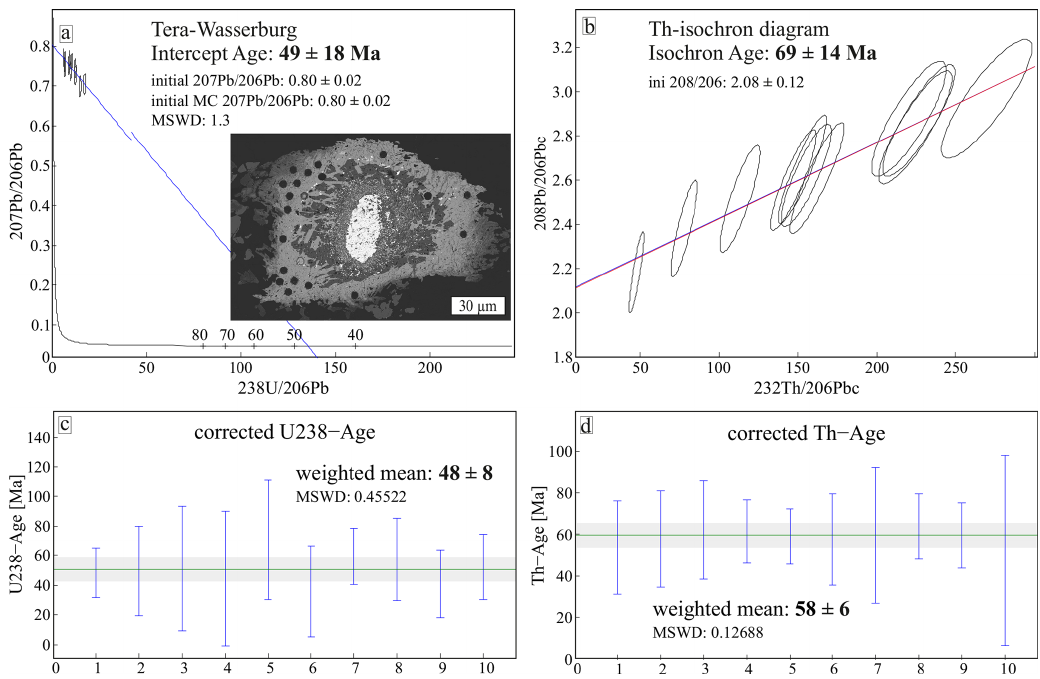
Figure 14. (a) Tera–Wasserburg and (b) Th–Pb-isochron diagram for allanite from sample FH27. (c, d) U and Th ages of the measurement points after correction for common